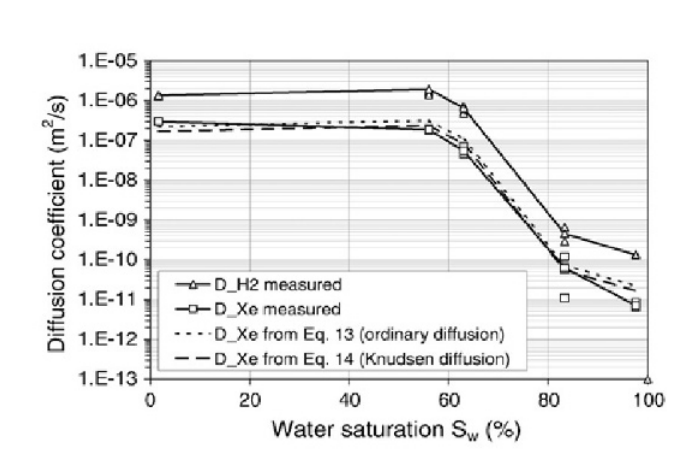
Fig. 3: Dihydrogen and xenon diffusion in hydraulic binders [5].